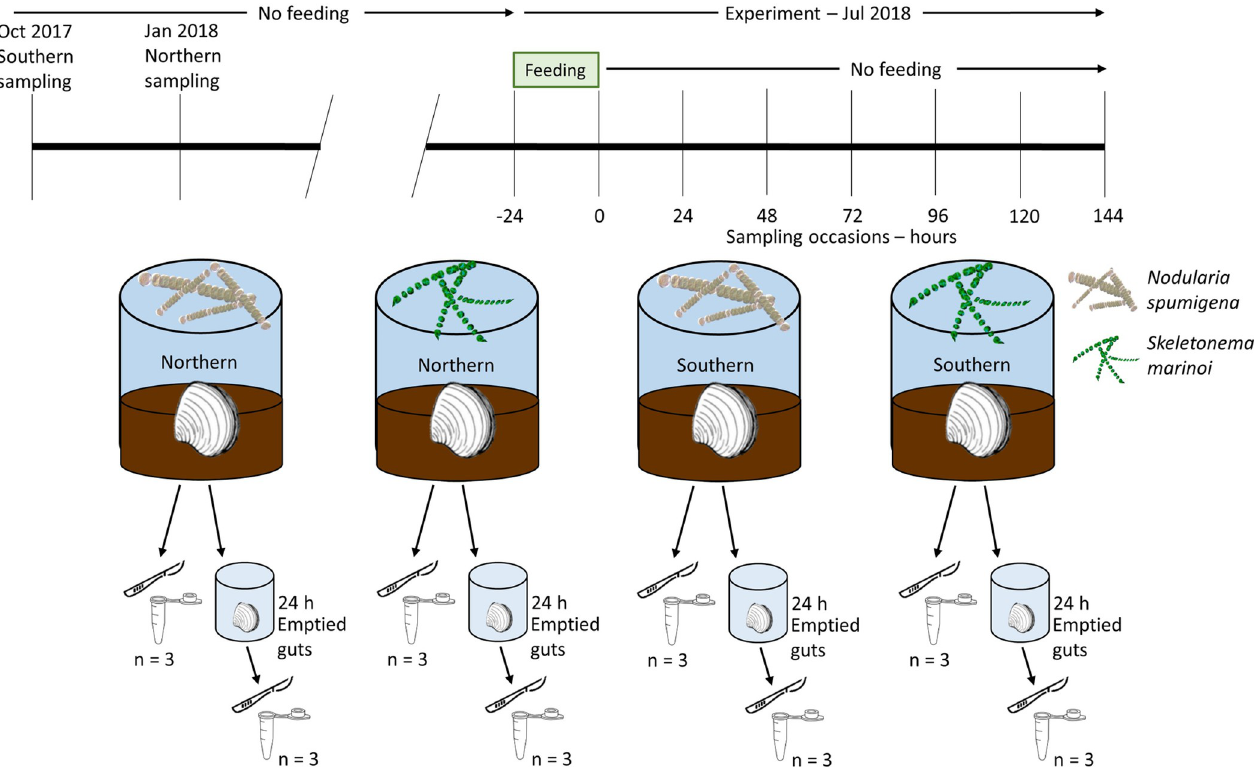
Fig 1. Experimental timeline and setup. Timeline (top) and experimental setup (bottom). Northern Macoma balthica samples were taken from the northern Stockholm archipelago, while southern samples were taken from the southern Stockholm archipelago. Each regional group was fed either the cyanobacteria Nodularia spumigena (brown) or the diatom Skeletonema marinoi (green), to create four treatments, and allowed to feed for 24 hours before the food source was removed. Samples were taken every 24 hours for one week, and either dissected and frozen immediately (left samples, represented by scalpel and tube) or allowed to empty their guts for 24 hours in freshwater before dissection and freezing (right; see S1 File for more information). All clams were kept in their original sediment without feeding for at least six months at the time of experiment